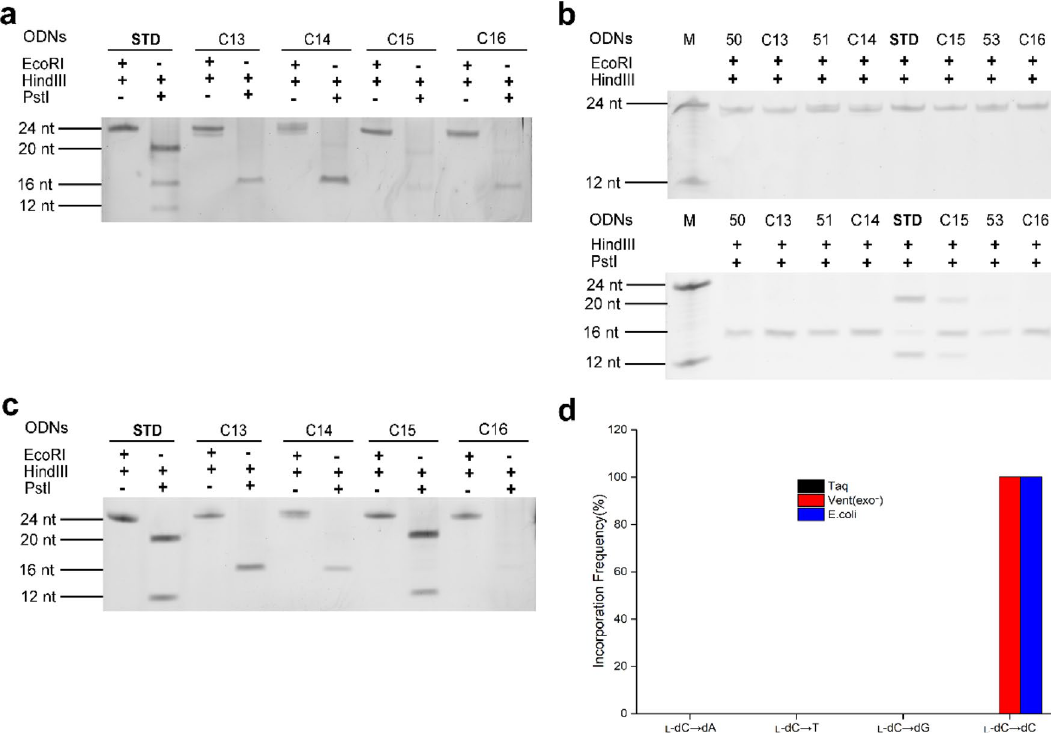
Figure 2. PAGE analysis of restriction fragments of replication products arising from the l-dC lesion-bearing genome ( a ) Taq DNA polymerase ( b ) Vent (exo - ) DNA polymerase ( c ) E. coli cells and ( d ) its mutation